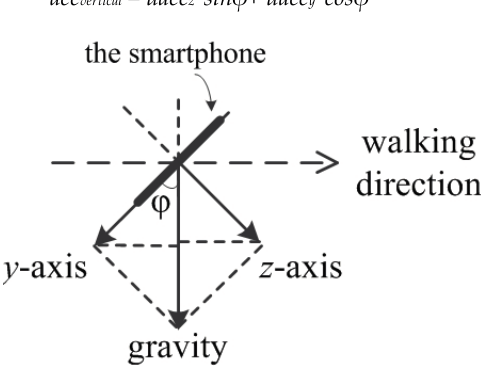
Figure 3. Calculation of vertical